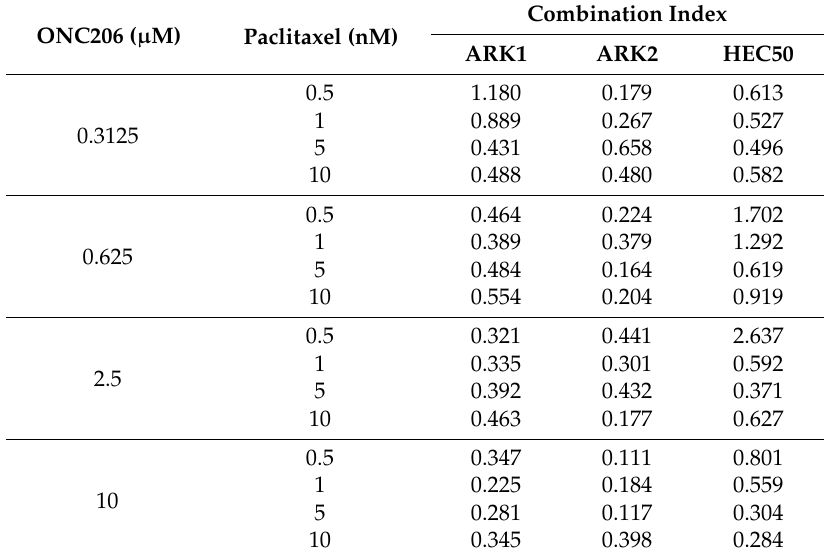
Table 1. Combination Index of ONC206 in combination with paclitaxel in uterine serous cancer